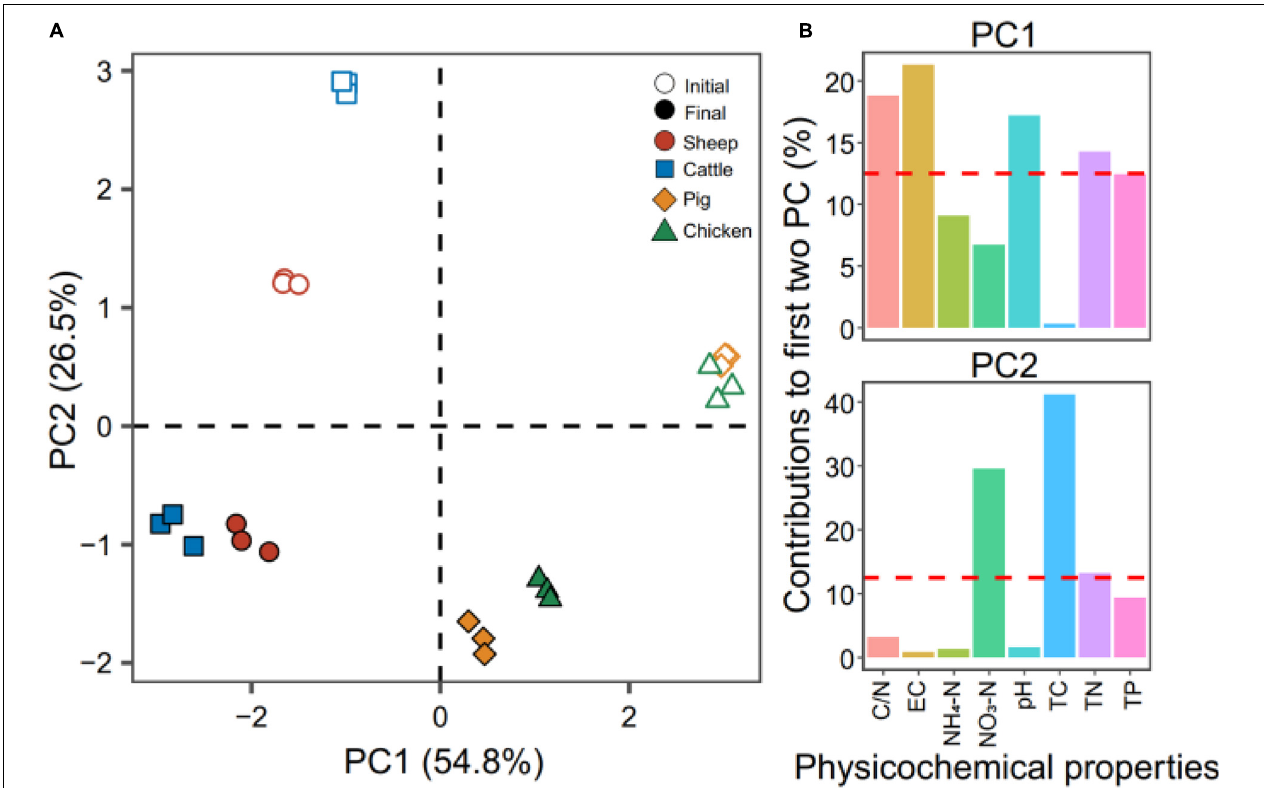
FIGURE 1 | Principal component analysis of the physicochemical compost properties at the initial (open symbols) and final (filled symbols) phases of composting. In panel (A) , colors correspond to different types of manure used for composting. Panel (B) shows the contribution of each physiochemical property on the first two principal components in panel A that explained 81.3% of the total variation (54.8 and 26.5% for PC1 and PC2, respectively). Red dashed lines in panel (B) indicate the theoretical contribution of physicochemical properties. N = 3 for each type of manure